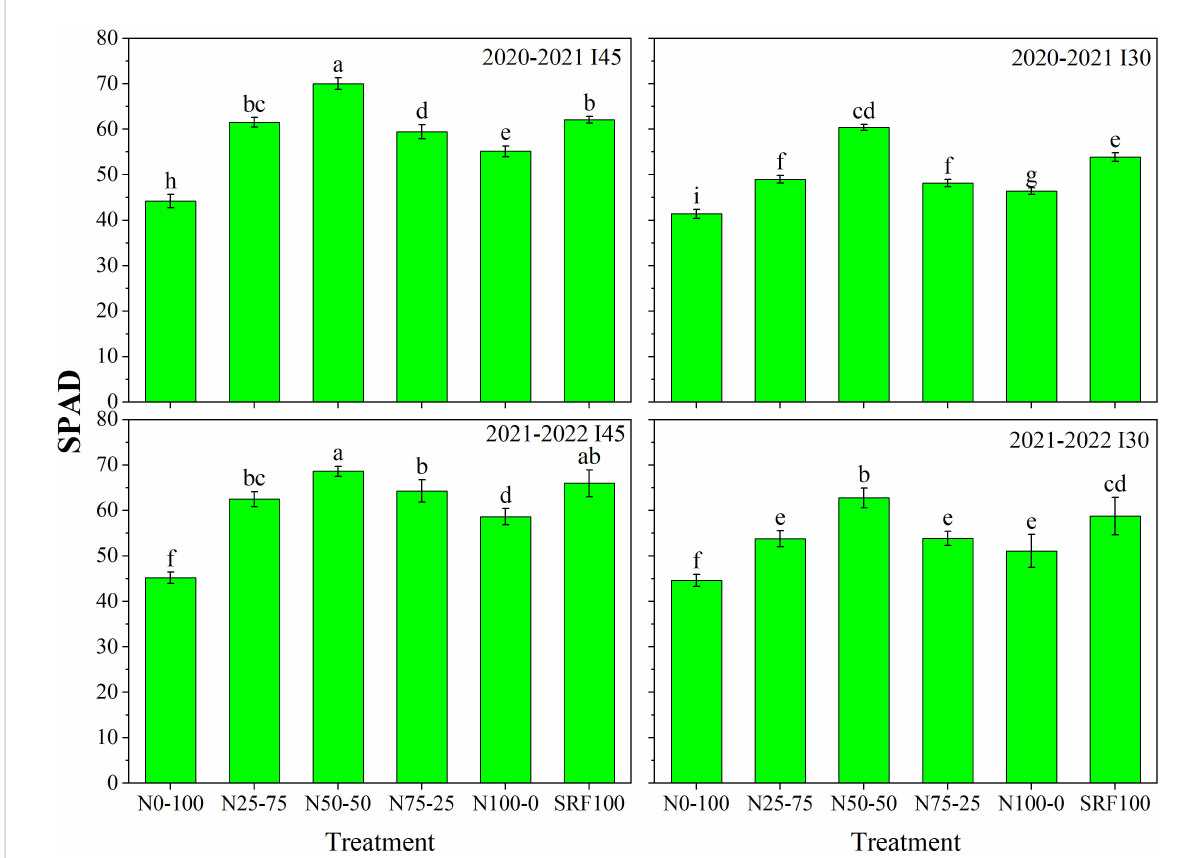
FIGURE 5 Effects of different irrigation scheduling and nitrogen application modes on SPAD chlorophyll during 2020-2021 and 2021-2022 winter wheat- growing seasons. Each value indicates the mean of three replicates ± standard deviation and the different letters on top of the error bar represent a signi fi cant difference at P <